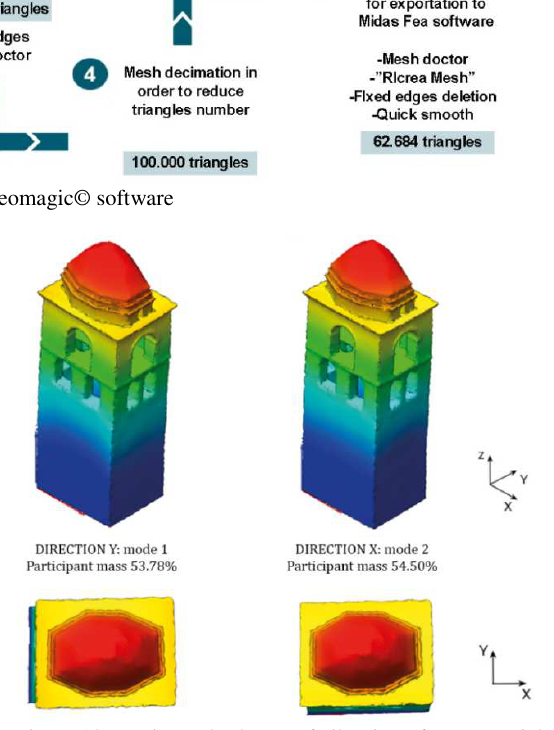
Figure 10 - Main mode shapes of vibration of one material model